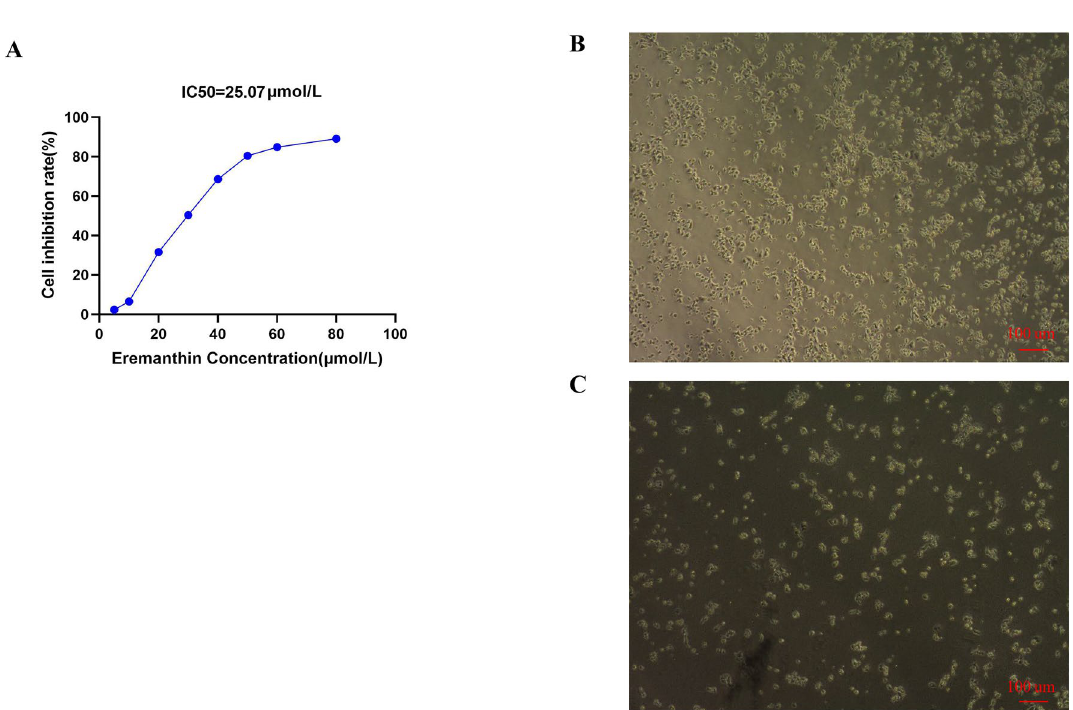
Figure 15. The graph of eremanthin inhibiting AGS growth. ( A–C ) show the growth state of AGS cells in different groups after 24 h of dosing. ( A ) The IC50 of eremanthin on AGS cells was 25.07 μmol/L, ( B ) represents the control group, and ( C ) represents the eremanthin